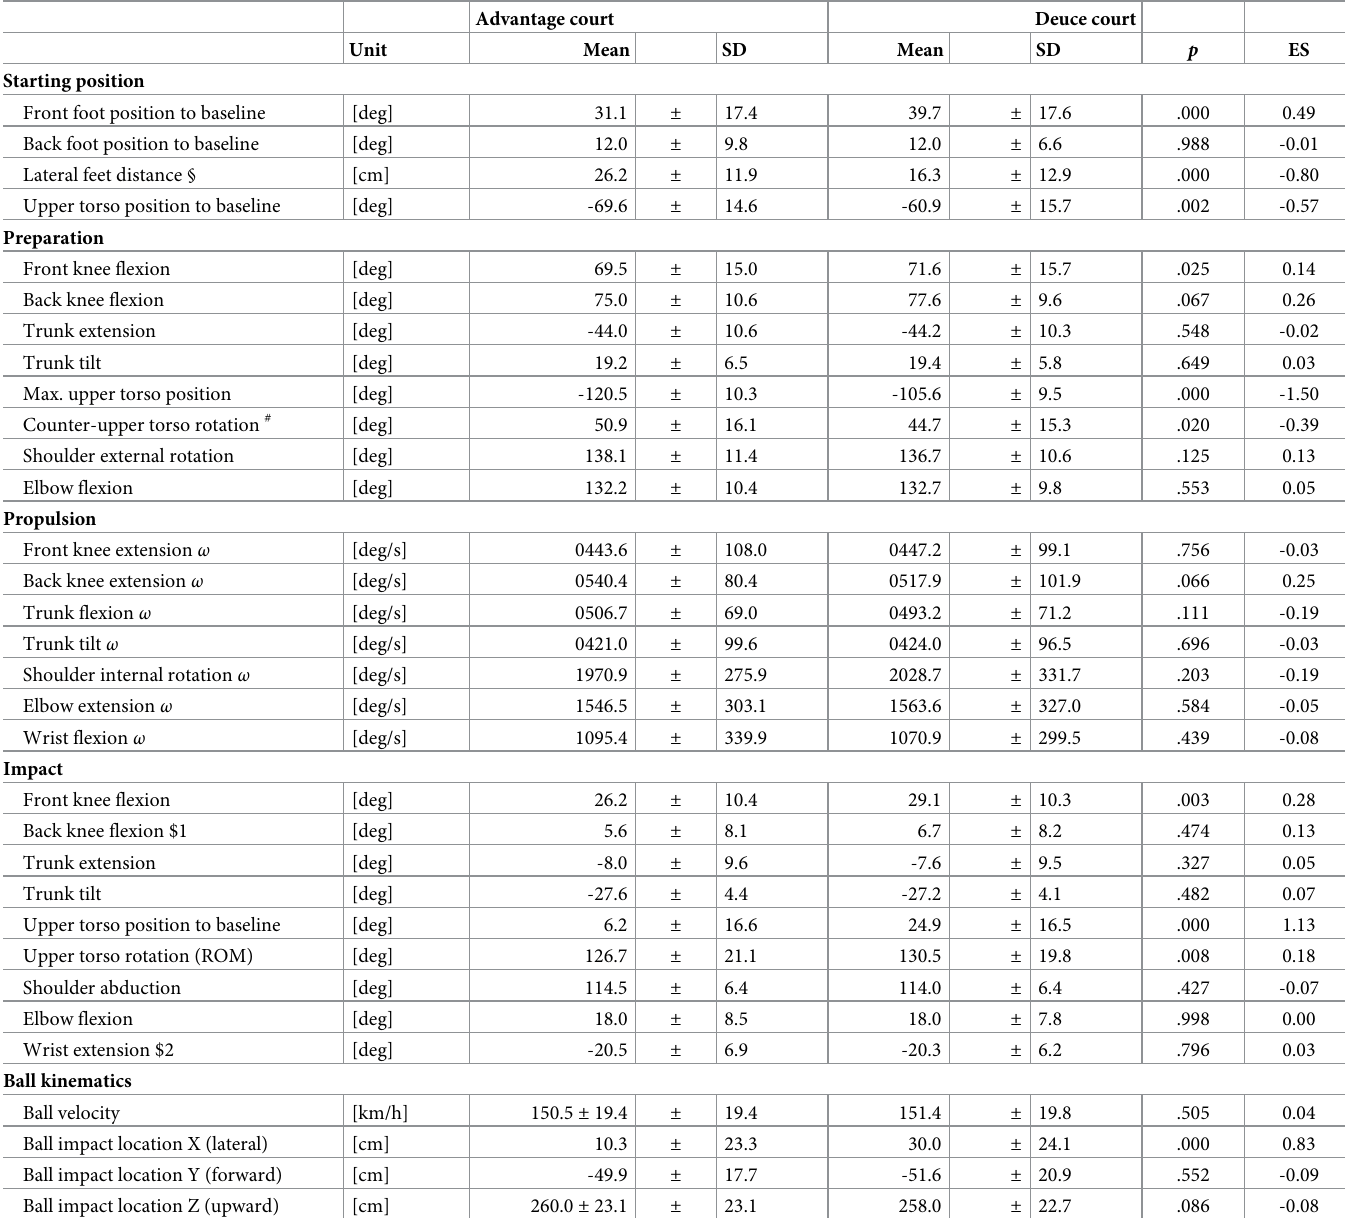
Table 1. Peak and terminal kinematic variables of interest for the ad and deuce service